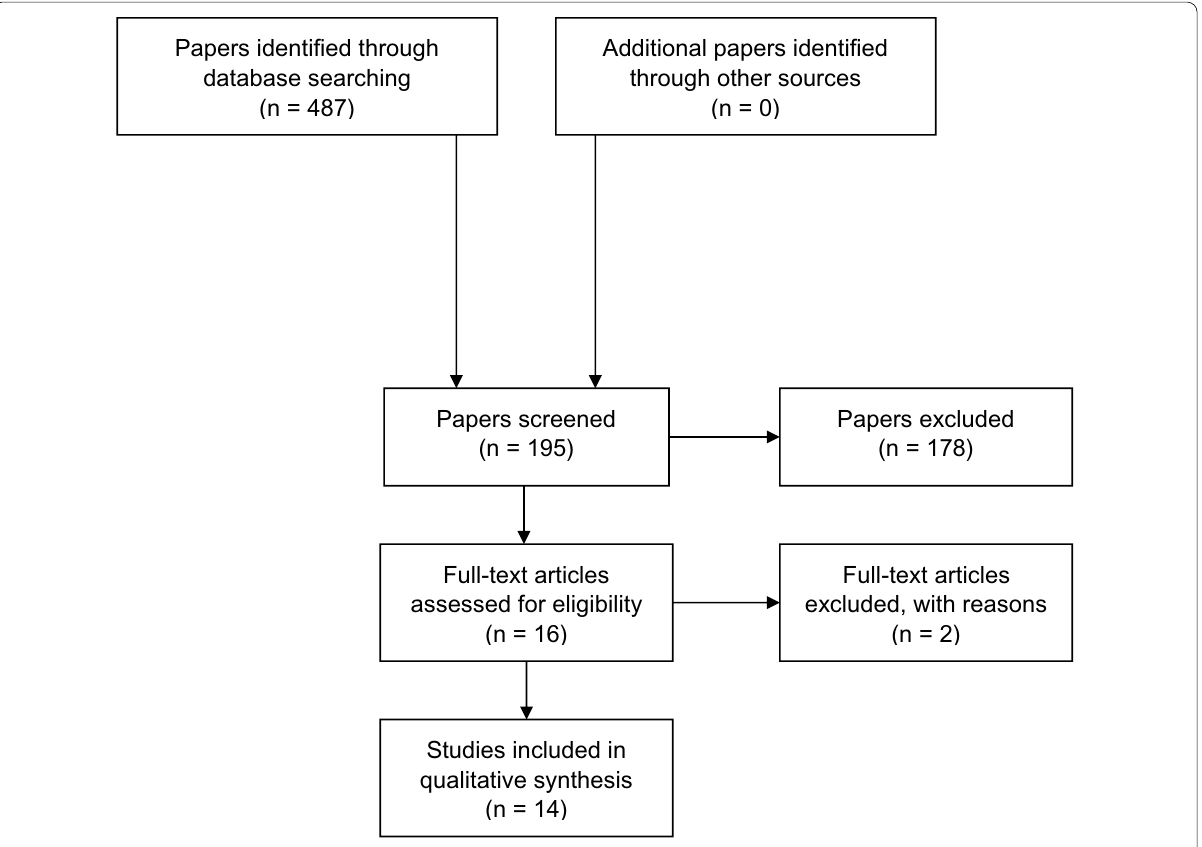
Fig. 2 Prisma flow diagram of the selection of papers